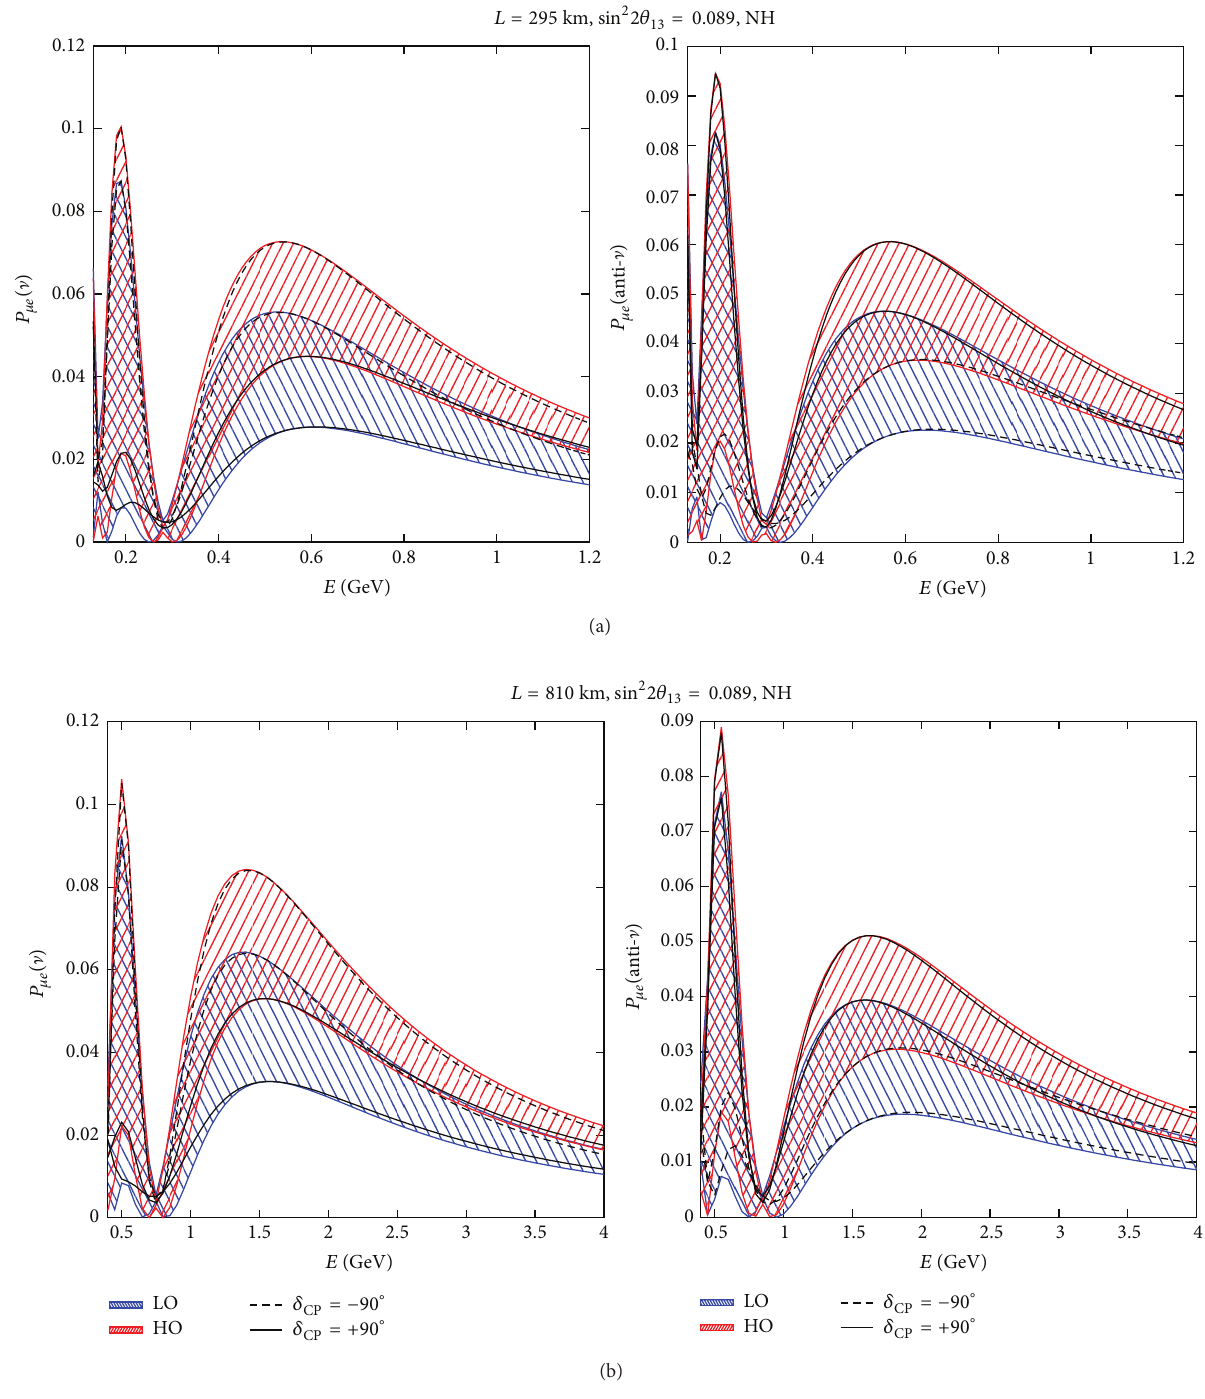
Figure 4: 𝑃 𝜇𝑒 as a function of neutrino energy. Here, the bands correspond to different values of 𝛿 = 90 ∘ ( 𝛿 = −90 ∘ ) case is shown by the solid (dashed) line. The red (blue) band is for HO with sin 2 𝜃 band, the probability for 𝛿 CP CP (LO with sin 2 𝜃 23 = 0.41 ). The left panel (right panel) is for ] ( ] ). The upper panels are drawn for the T2K baseline of 295 km. The lower panels are for the NO ] A baseline of 810 km. Here, we consider sin 2 2𝜃 13 = 0.089 and